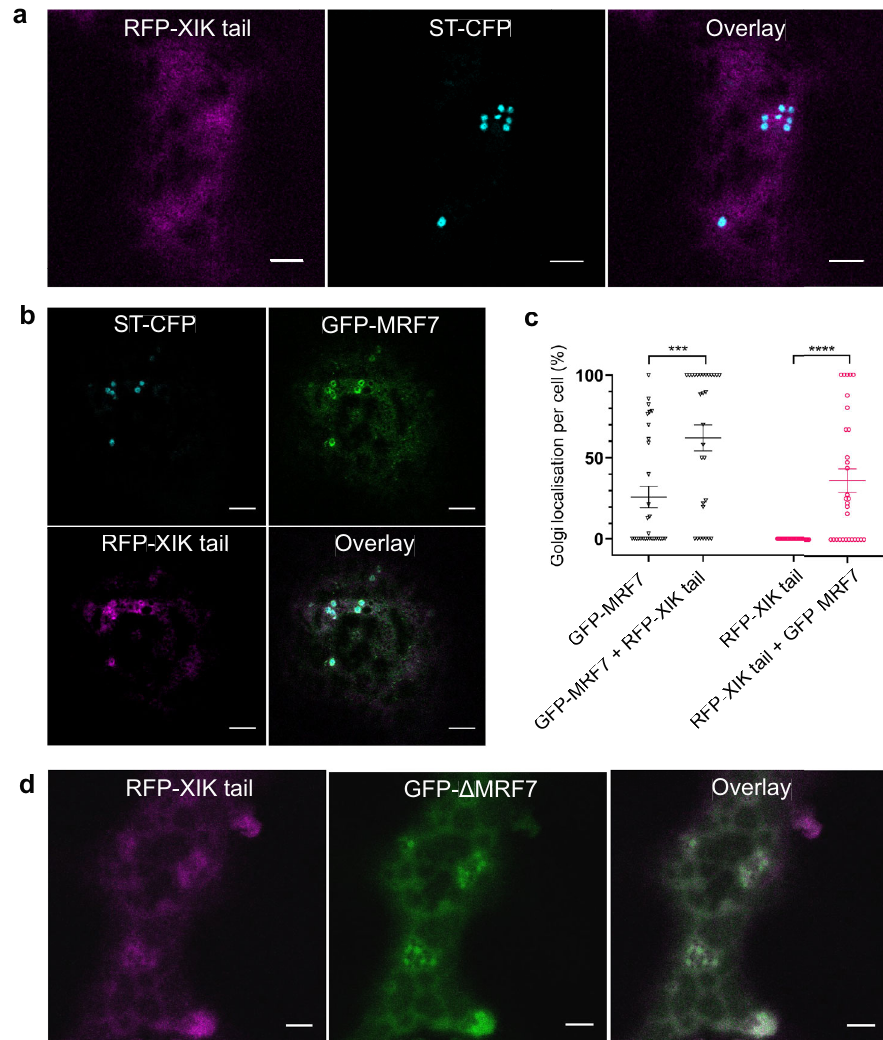
Fig. 5 Myosin XI-K tail relocates from the cytosol to the Golgi surface in the presence of GFP-MRF7. a Myosin RFP-XIK tail is present in the cytosol when coexpressed with the Golgi marker (StCFP, cyan). b Myosin RFP-XIK tail (magenta) is present on the Golgi surface and in the cytosol when coexpressed with GFP-MRF7 (green) and the Golgi marker (StCFP cyan), see overlay image. c Quanti fi cation of the GFP-MRF7 (black datapoints) and RFP- XIK (magenta datapoints) tail Golgi localisation per cell, when expressed with Golgi marker only, or when expressed with each other and the Golgi marker. RFP-XIK tail signi fi cantly increases the Golgi localisation of GFP-MRF7 (black datapoints), similarly, GFP-MRF7 signi fi cantly increases Golgi localisation of RFP-XIK tail (magenta datapoints). The analysis was performed on 30 cells across three independent experiments; each datapoint represents one cell (mean ± SEM), *** p < 0.001, **** p < 0.0001, Mann – Whitney U test. d Myosin RFP-XIK tail (magenta) remains in the cytosol when coexpressed with GFP- Δ MRF7 (green), see overlay image. All constructs were transiently expressed in tobacco leaf epidermal cells and imaging was performed two days post- in fi ltration. Scale bar = 5 µ